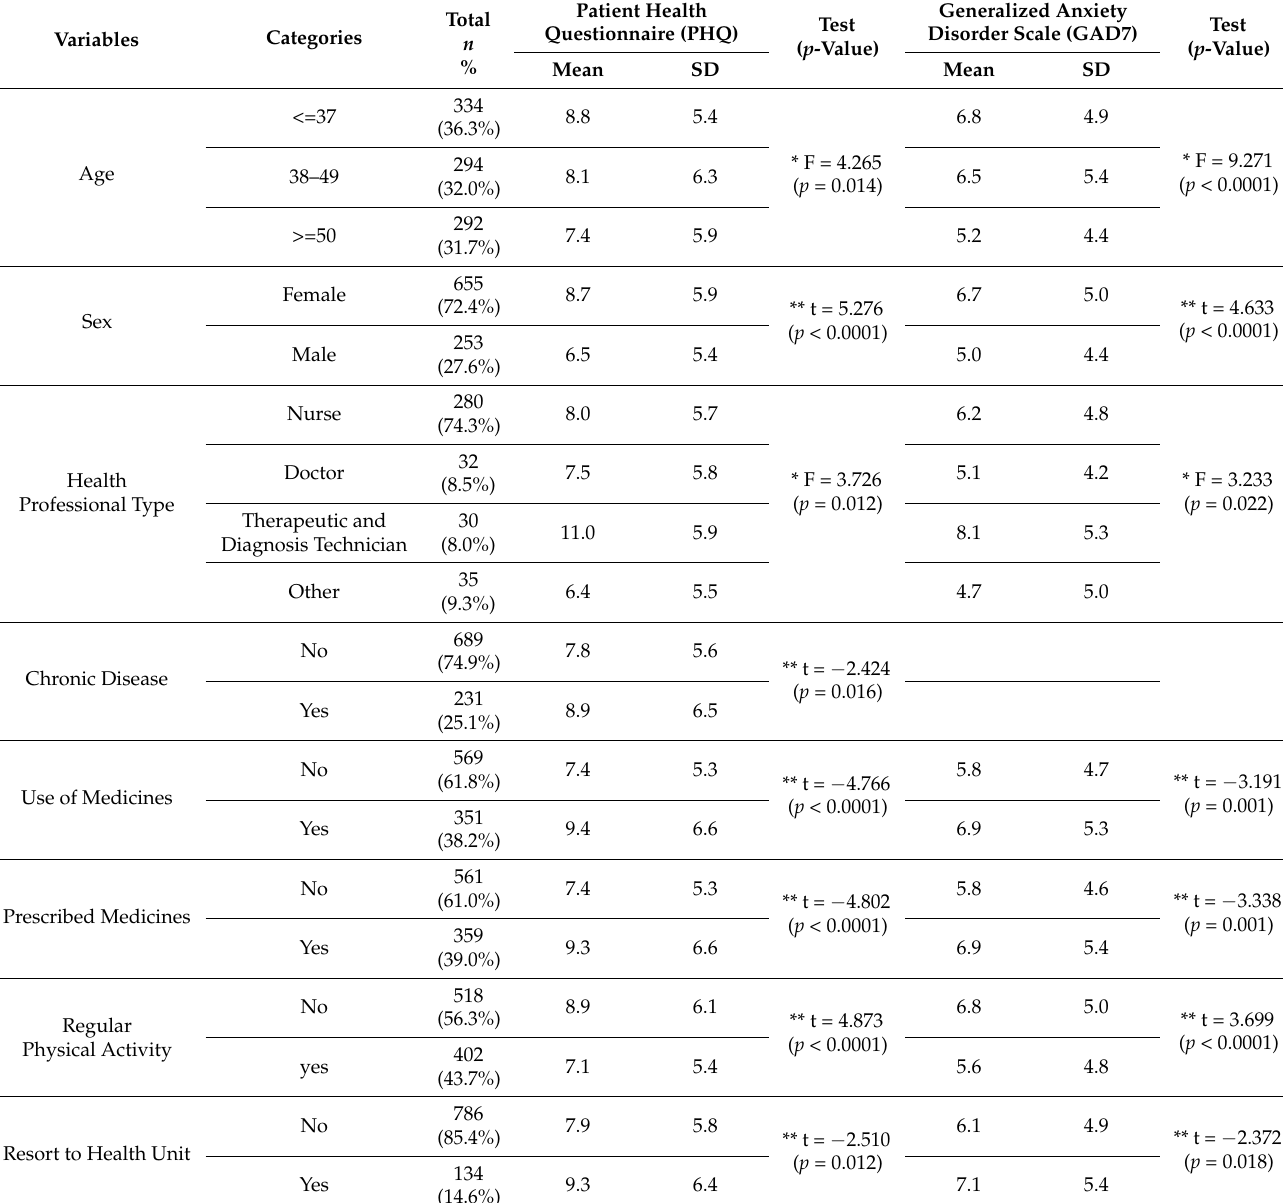
Table 3. Depressive symptoms and generalized anxiety levels during the quarantine, according the Sociodemographic and Health variables ( n =